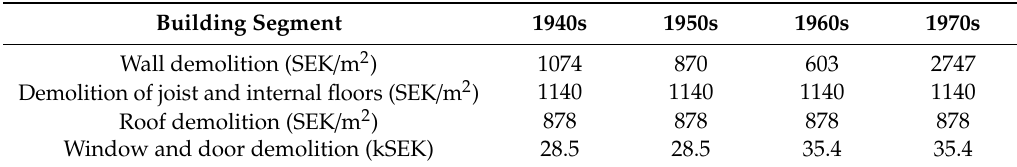
Table 10. Demolition costs for building parts in the 1940s, 1950s, 1960s, and 1970s buildings from Wikells Sektionsfakta